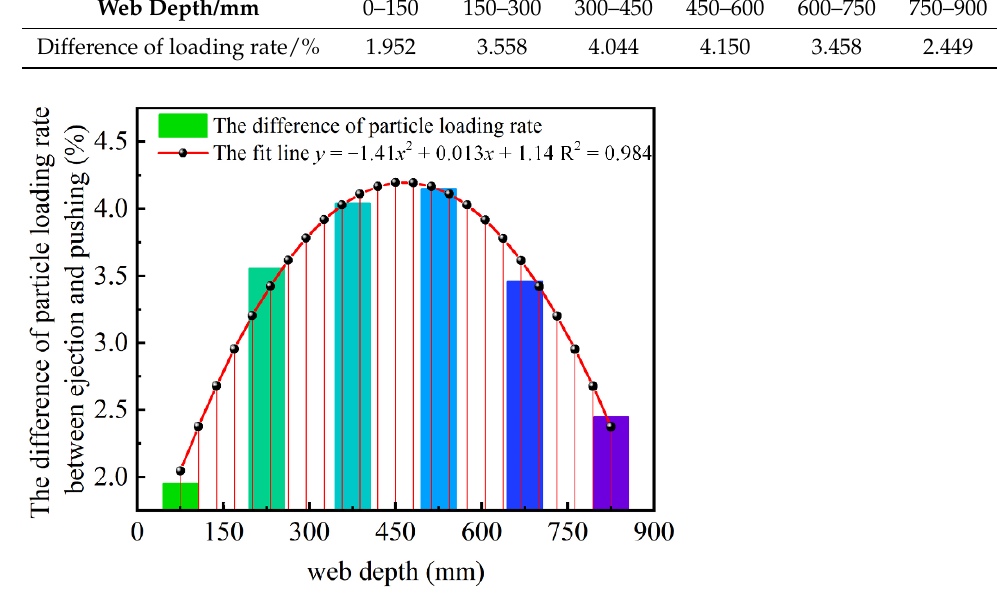
Figure 24. The difference in loading rate for particles with different web depths under ejection and pushing conditions. Table 2. The statistical results of differences in loading rate for particles with different web depths under ejection and pushing conditions.